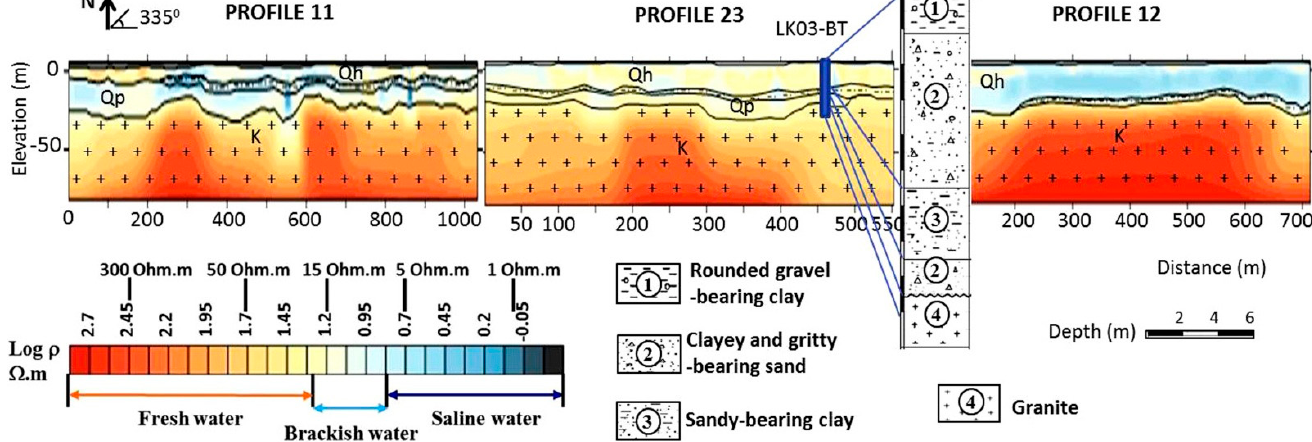
Figure 9. Resistivity distribution of the three consecutive profiles on the left bank of the upstream part. The distance between LK03-BT and the profiles is small enough (approximately 500 m) to compare the borehole log with ERT results. Qh, Qp: Holocene and Pleistocene aquifers; K: Deo Ca Cretaceous granite complex.